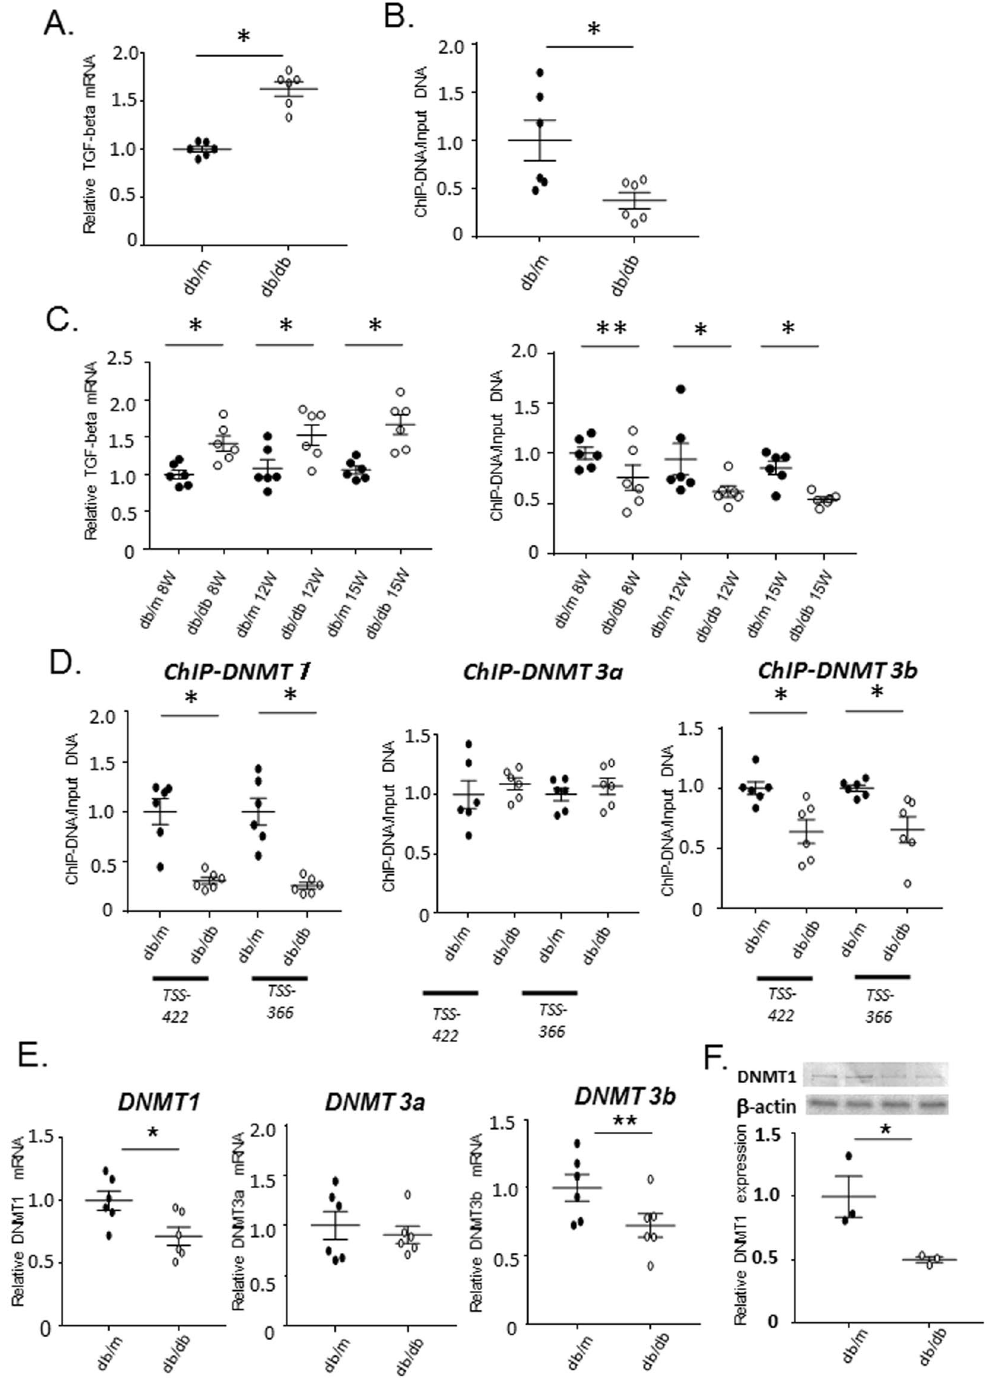
Figure 4. DNA demethylation and upregulation of Tgfb1 in mesangial cells of db/db mice. ( A ) Real-time PCR of Tgfb1 mRNA (normalized to Gapdh ) in primary cultured mesangial cells from db/m and db/db mice. Open circle: The expression of Tgfb1 mRNA in db/db mice significantly higher than that in db/m mice. Data represent the mean ± SEM. n = 6. Filled circles: db/m mice; open circles: db/db mice. ( B ) Quantitation of DNA methylation (using a MethylCollector Ultra kit) in mesangial cells from 15-week-old db/m controls and db/ db mice. Results of amplification from the − 422 bp relative to the transcription start site (TSS) regions are shown. DNA methylation of db/db mice is significantly lower than that of db/m mice . n = 6. ( C ) Time course real-time PCR experiments demonstrating Tgfb1 mRNA (normalized to Gapdh ) expression and quantitation of DNA methylation using a MethylCollector Ultra kit in 8-, 12-, and 15-week-old (8 W, 12 W, and 15 W, respectively) db/m and db/db mice. Following the significant difference in Tgfb1 mRNA at 8 week and the slight, but insignificant, decrease in DNA methylation in mesangial cells of db/db mice at 8 weeks, both parameters at 12 and 15 weeks significantly differed between db/m and db/db mice. n = 6. ( D ) ChIP analysis of DNMTs